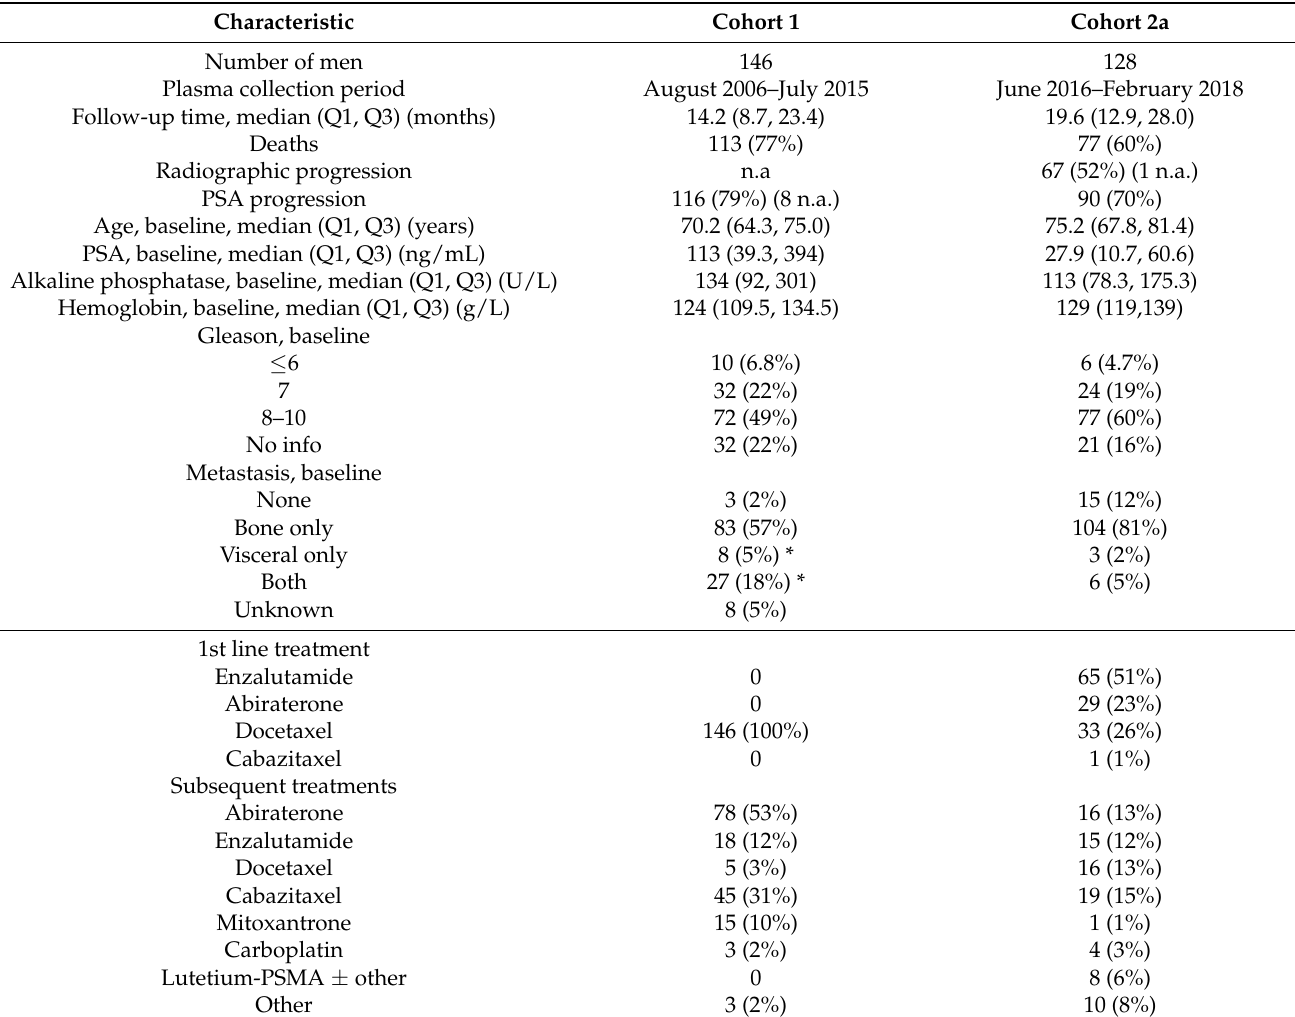
Table 1. Clinical characteristics of Cohorts 1 and Cohort 2a (Q1, first quartile; Q2, second quartile).